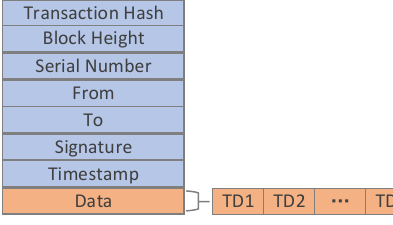
Figure 4. The structure of the